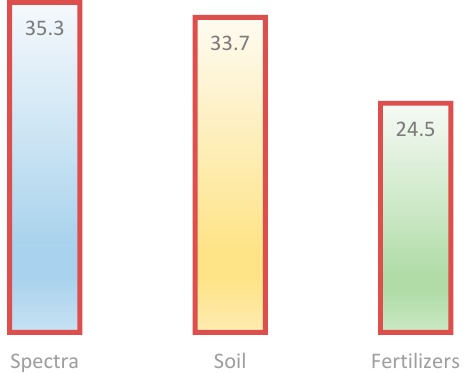
Figure 15. Averaged between-zone variation (CV%) for spectral, soil, and fertilizer data in the studied rice fields.